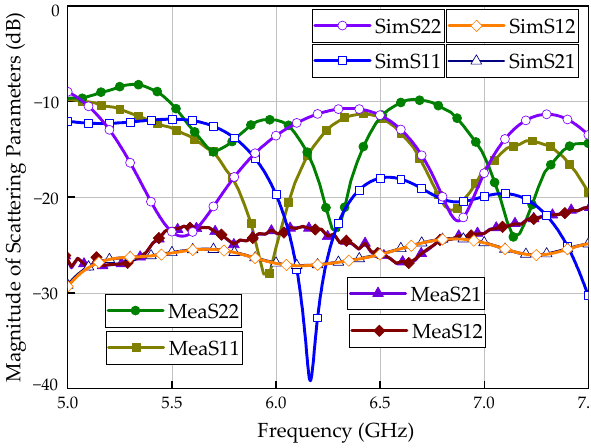
Figure 10. Simulated and measured magnitude of scattering parameters.